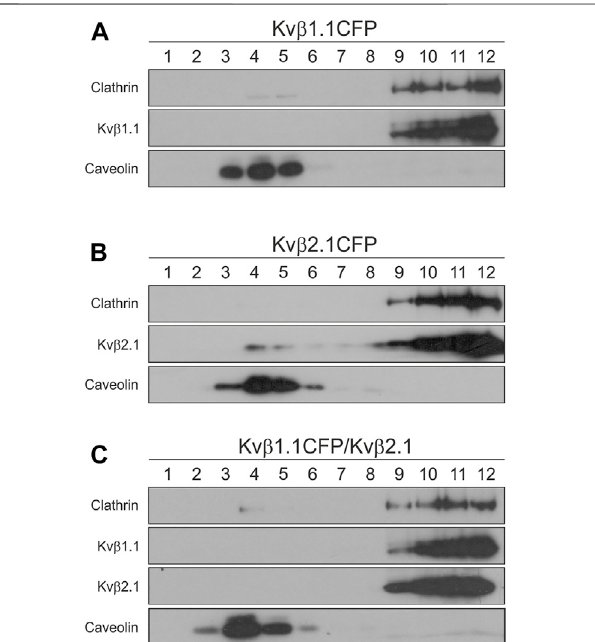
FIGURE 7 | Kv β 1.1 interaction shifts out Kv β 2.1 from lipid raft domains. HEK 293 cells were transfected with Kv β 1.1CFP, Kv β 2.1CFP and Kv β 1.1CFP-Kv β 2.1. Lipid rafts were isolated as described in the methods. One-milliliter fractions were sequentially collected from the top (1, high buoyancy) to the bottom (12, low buoyancy) of the tube. (A) Western blotting of lipid raft fractions of Kv β 1.1CFP. (B) Western blot analysis of lipid raft fractions of Kv β 2.1. (C) Western blotting of lipid raft fractions of Kv β 1.1CFP and Kv β 2.1 cotransfection. While caveolin identi fi es fl oating lipid rafts, clathrin indicates nonlipid raft